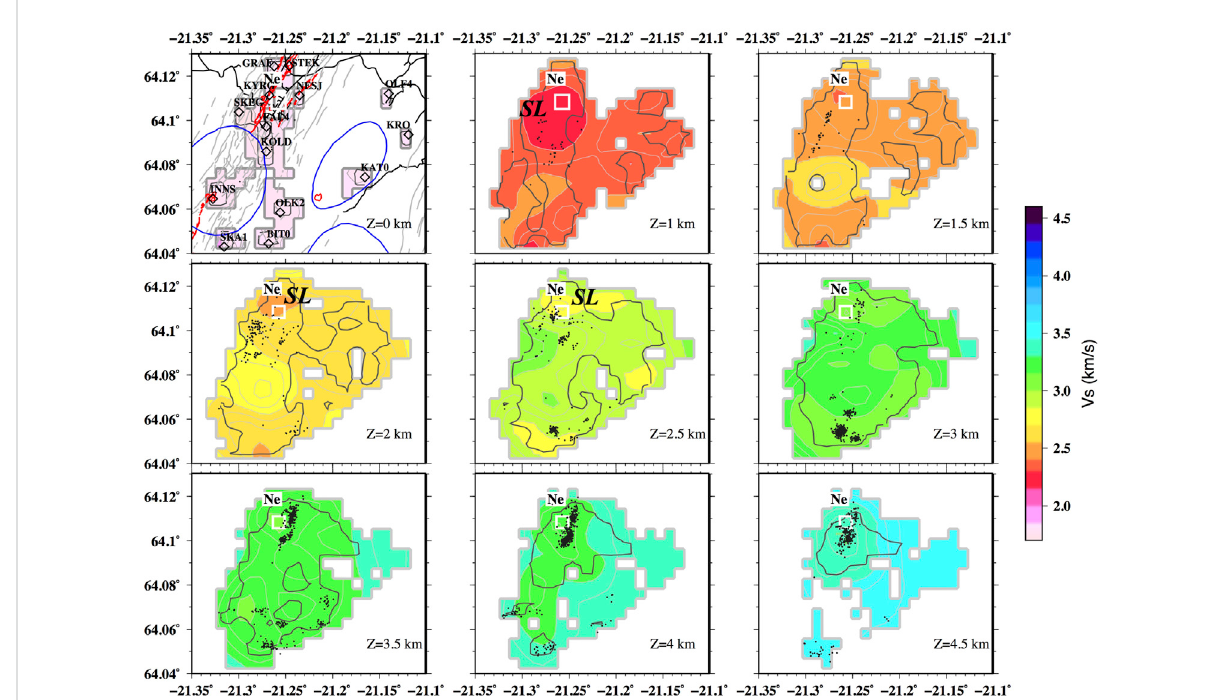
FIGURE 5 3D tomographic model: v S horizontal slices. Black dots are earthquakes within 1 km around each slice from the 2,358 high quality events used for the tomography. The regions not covered by the ray paths are shown in white. The dark gray contour line delimitates the well-resolved area inferred by the Derivative Weight Sum (DWS). The uppermost slide to the left (z = 0 km) shows for orientation the seismic stations, roads in black, fi ssures and craters in red, fractures in gray and blue lines are the three volcanic centers of the region. The Nesjavellir power plant is located in the white square, labeled Ne. SL is a low v S anomaly (discussed in Section